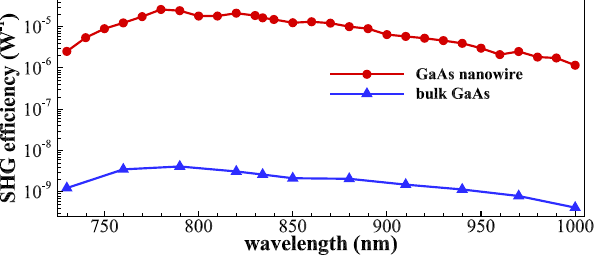
Figure 4. Conversion efficiency of SHG signals over a wide FW wavelength range.